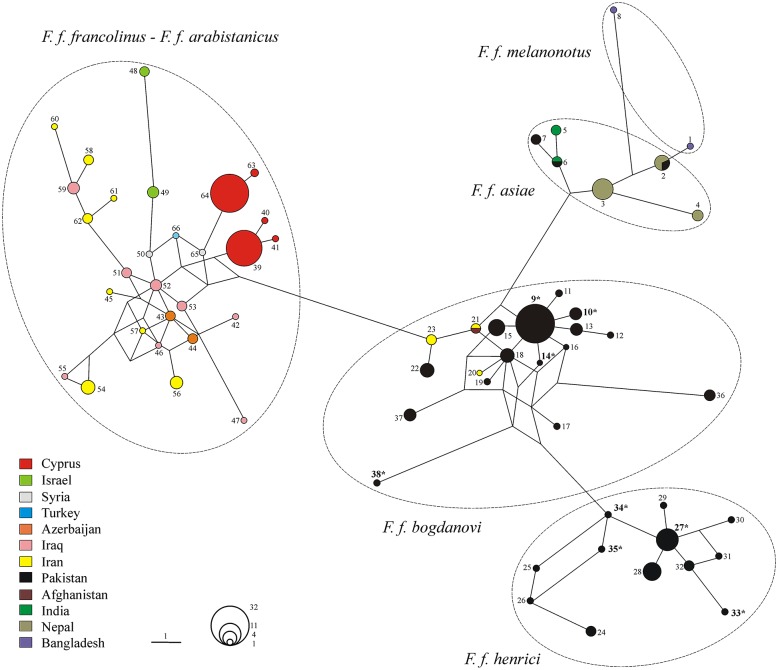
Black francolin haplotype network as computed with network.The size of circles corresponds to the number of haplotypes (H1 to H66) and the length of lines between them is proportional to the number of mutations. The colour of each country is indicated as well as the number of each haplotype (S1 Table). Black francolin subspecies are indicated as well. Haplotypes including new sequences with respect to the study of Forcina et al. [34] are reported in bold with an asterisk (H9, H10, H14, H27, H33-35 and H38).